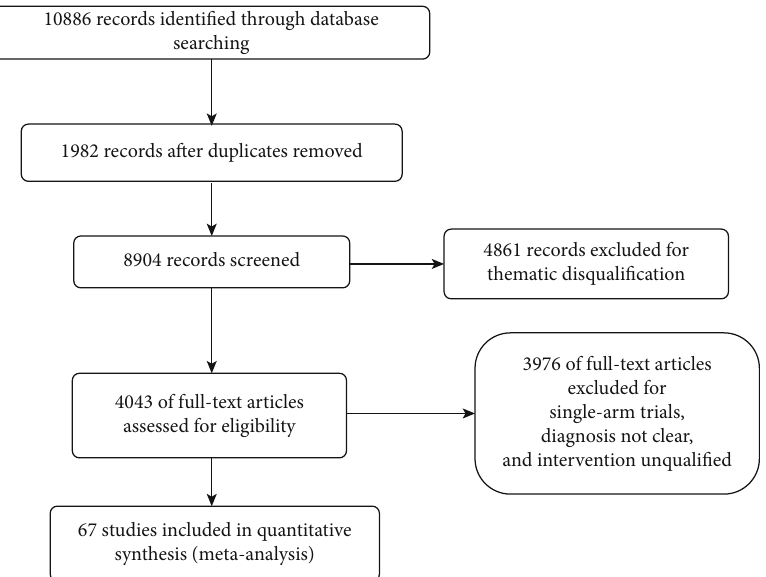
Figure 2: Process of study extracted for the